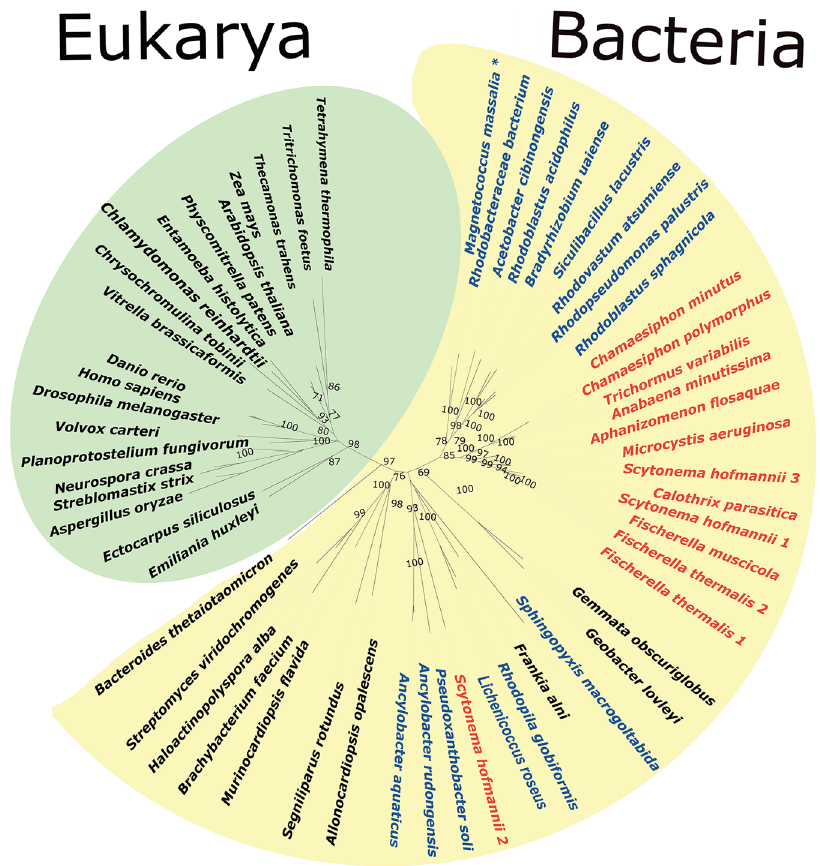
Figure 6. Unrooted phylogenetic tree of calpain catalytic CysPC domains. Cyanobateria are in red and alphaproteobacteria in blue. *Recent phylogenetic studies of alphaproteobacteria suggested that magnetotactic bacteria including Magnetococcus spp. should be excluded from alphaproteobacteria and placed into the separate class Magnetococcia 56